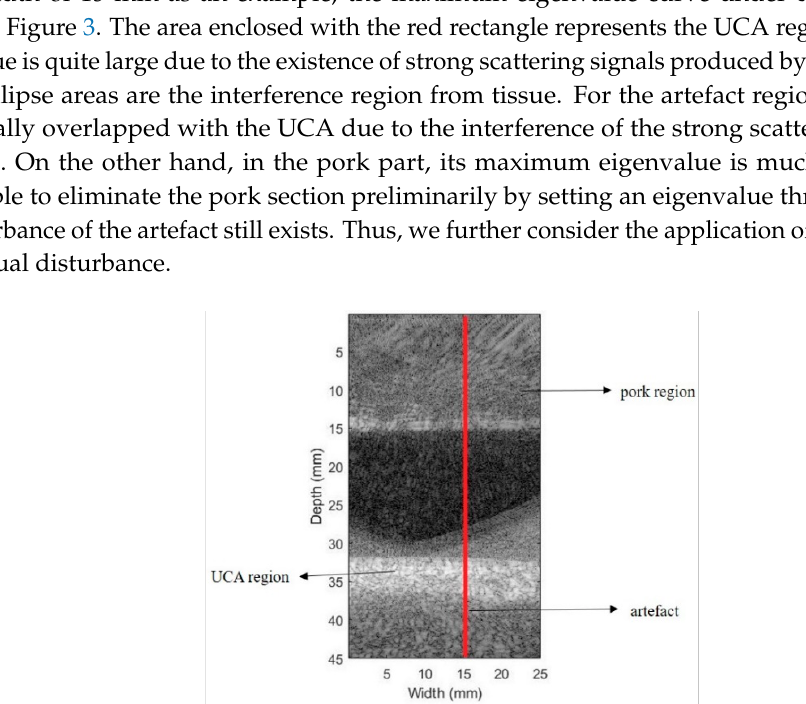
Figure 2. The image of the phantom (with pork) under delay-and-sum (DAS).